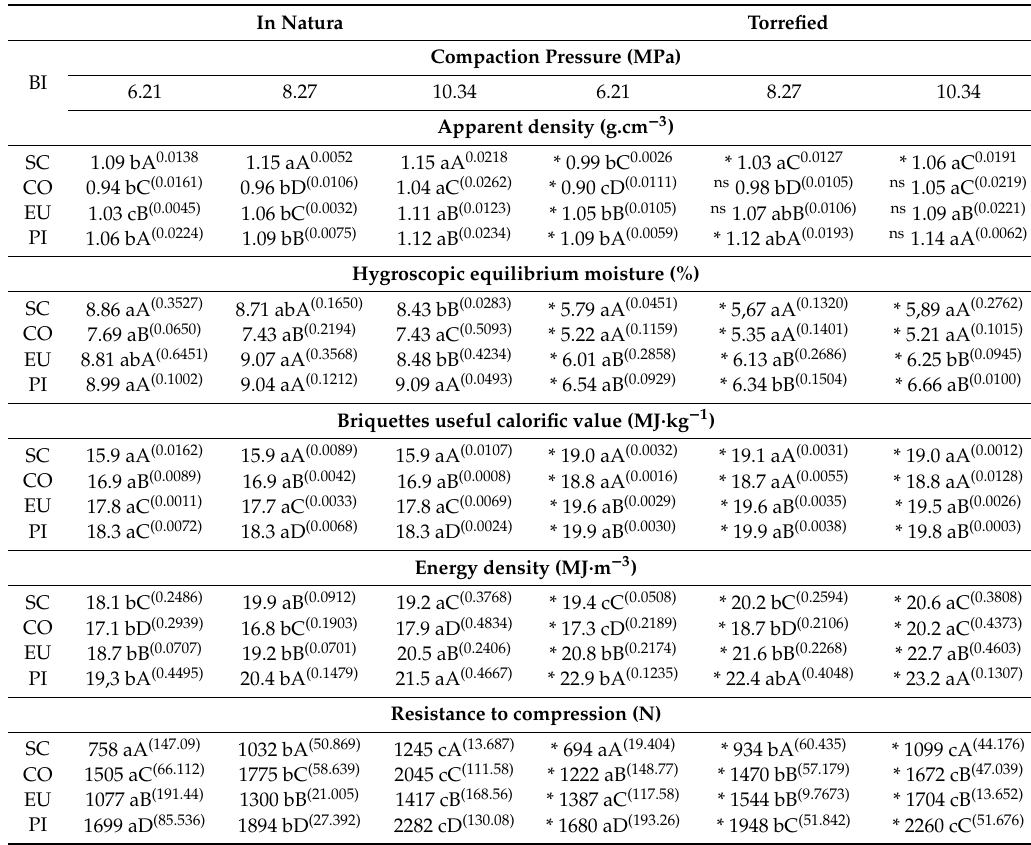
Table 2. Apparent density (g.cm − 3 ), hygroscopic equilibrium moisture (%), useful calorific value (MJ · kg − 1 ), energy density (MJ · m − 3 ), and resistance to compression (N) as a function of pressure (MPa), and the heat treatment e ff ect on briquettes made of sugarcane (SC), Co ff ea arabica (CO), Eucalyptus spp. (EU) and Pinus spp.